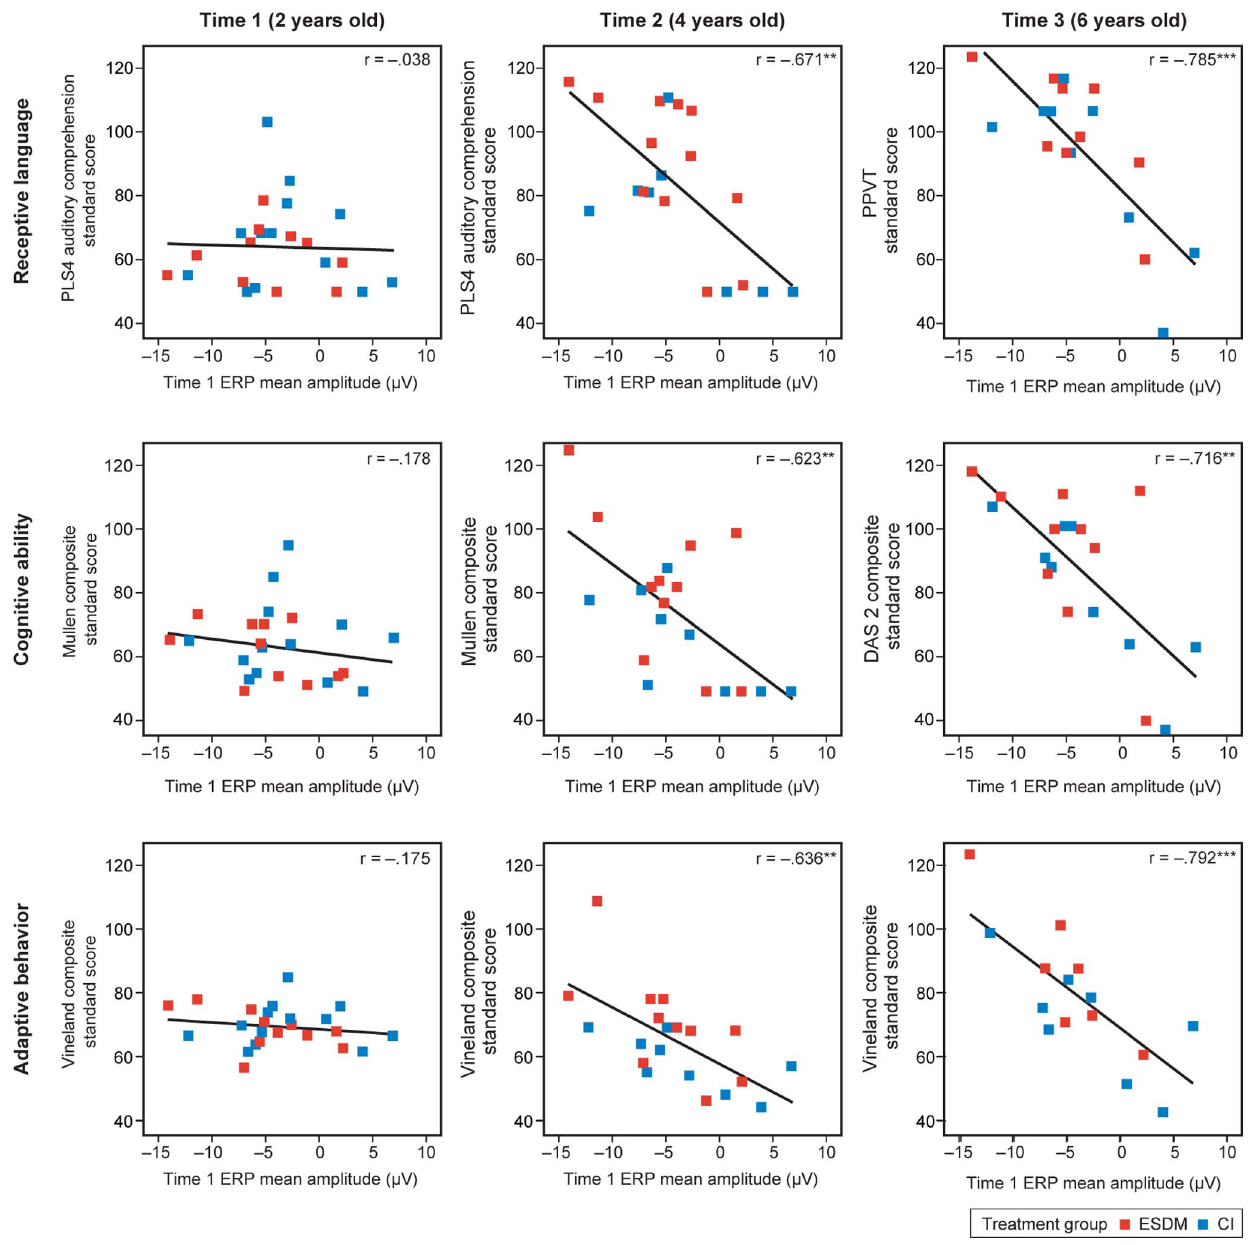
Figure 2. Time 1 ERP predicts later receptive language, cognitive ability, and adaptive behavior. Time 1 ERP predicts functional outcome at Time 2 (center) and Time 3 (right) in children with ASD enrolled in the ESDM (red) and CI (blue) intensive intervention groups. Time 1 ERP mean amplitude for known words (Time 1 ERP) appears on the x-axis, which is constant across all scatterplots. The specific behavioral measures of receptive language, cognitive ability, and adaptive behavior are expressed as norm referenced standard scores and appear on the y-axis. The scale for standard scores on the y-axis is constant across all scatterplots. Two-year-old children with ASD who produce a more negative Time 1 ERP amplitude have higher receptive language, cognitive ability, and adaptive behavior standard scores at the ages of 4 (Time 2, center) and 6 years (Time 3, right). Not all participants completed all behavioral measures at Time 3.